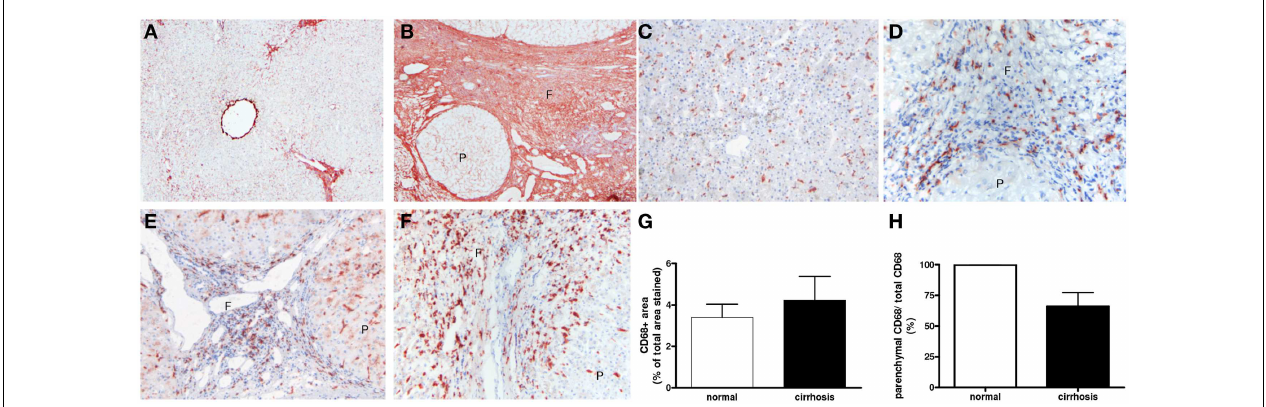
presence of macrophages in the collagenous fibrotic bands (F) . (G,H) Image analysis of CD68 staining in human livers. Reduced CD68 staining was found in the parenchymal area ( p ) of human cirrhotic livers as compared to normal. Magnifications: 40 × (A,B) and 100 × (C–F) . f, fibrotic matrix; p , liver parenchyma. N = 5 cirrhotic livers, N = 6 normal livers.